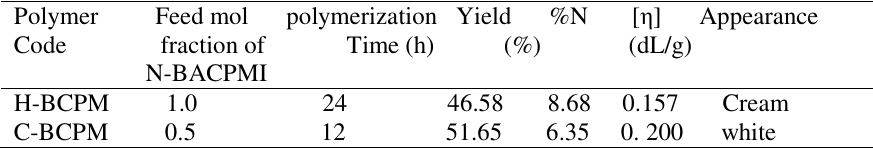
Table 1. Radical polymerization and copolymerization of N-BACPMI and n -butyl acrylate in THF at 65˚C.